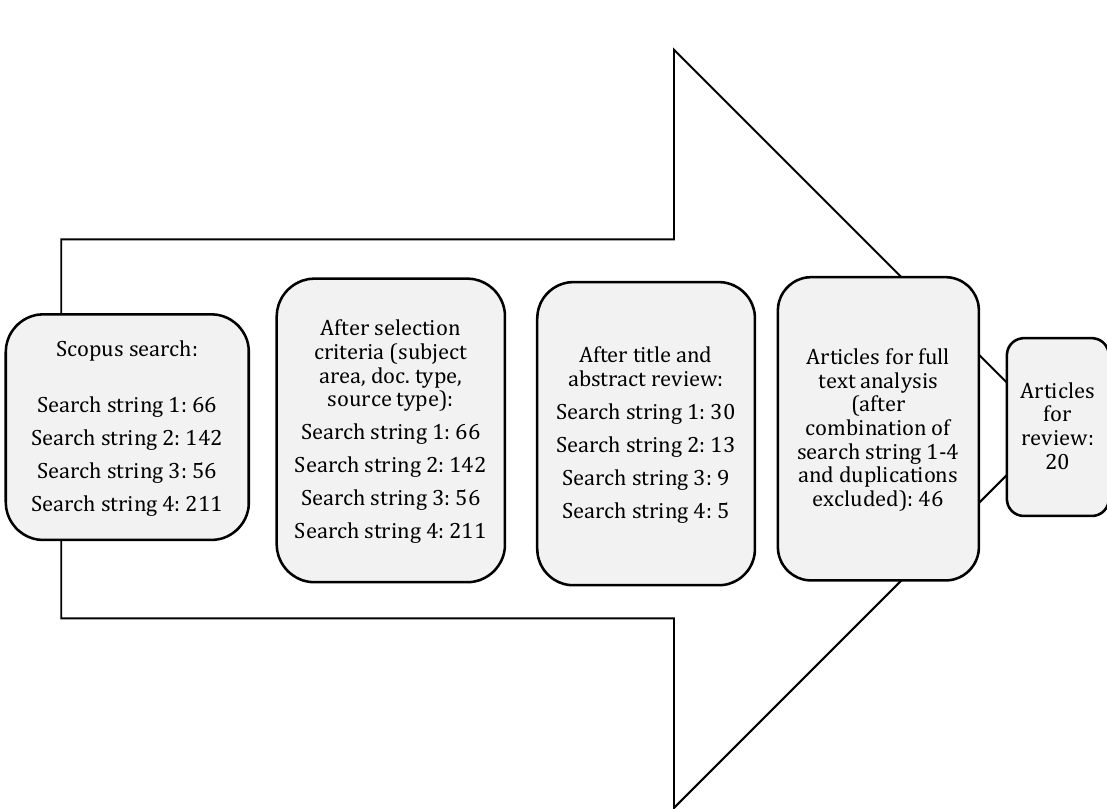
Figure 2. An overview of the literature search.